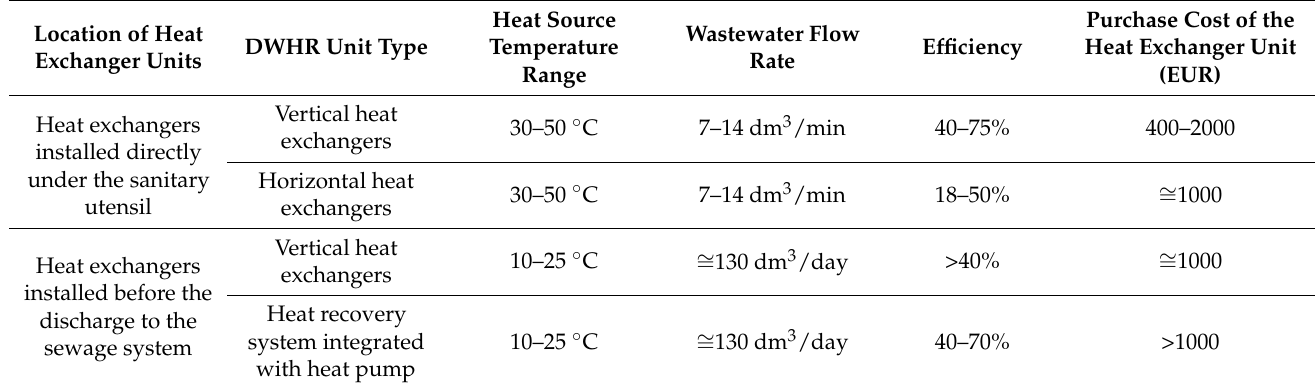
Table 3. Average efficiency of wastewater heat recovery